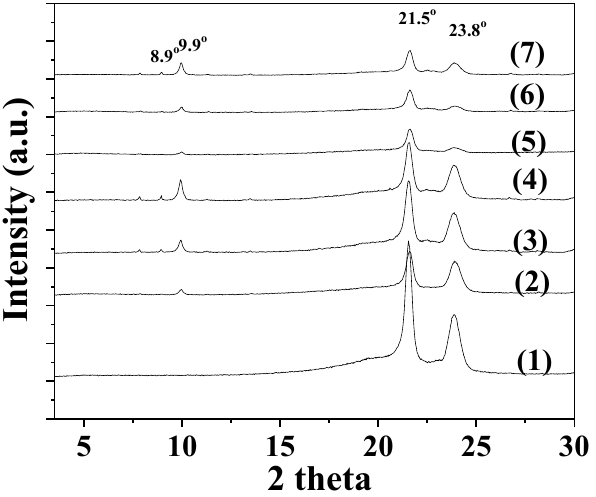
Figure 2. XRD plots of (1) pure LDPE, (2) LDPE/5NZ, (3) LDPE/10NZ, (4) LDPE/15NZ, (5) LDPE/5TO@NZ, (6) LDPE/10TO@NZ, and (7) LDPE/15TO@NZ films.